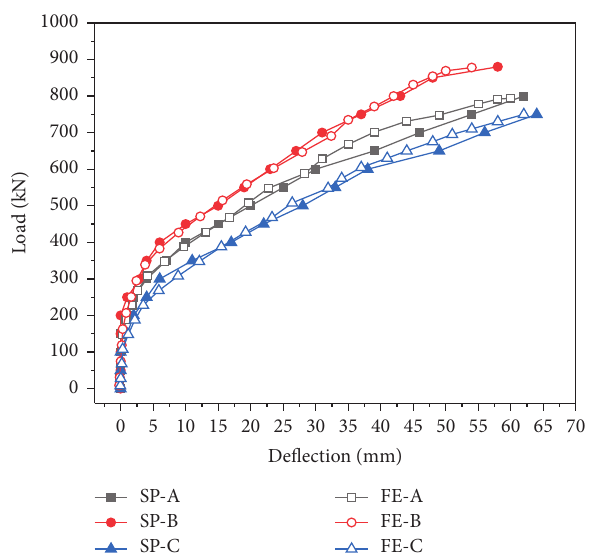
Figure 11: Comparison of load-deflection curves from tests and numerical